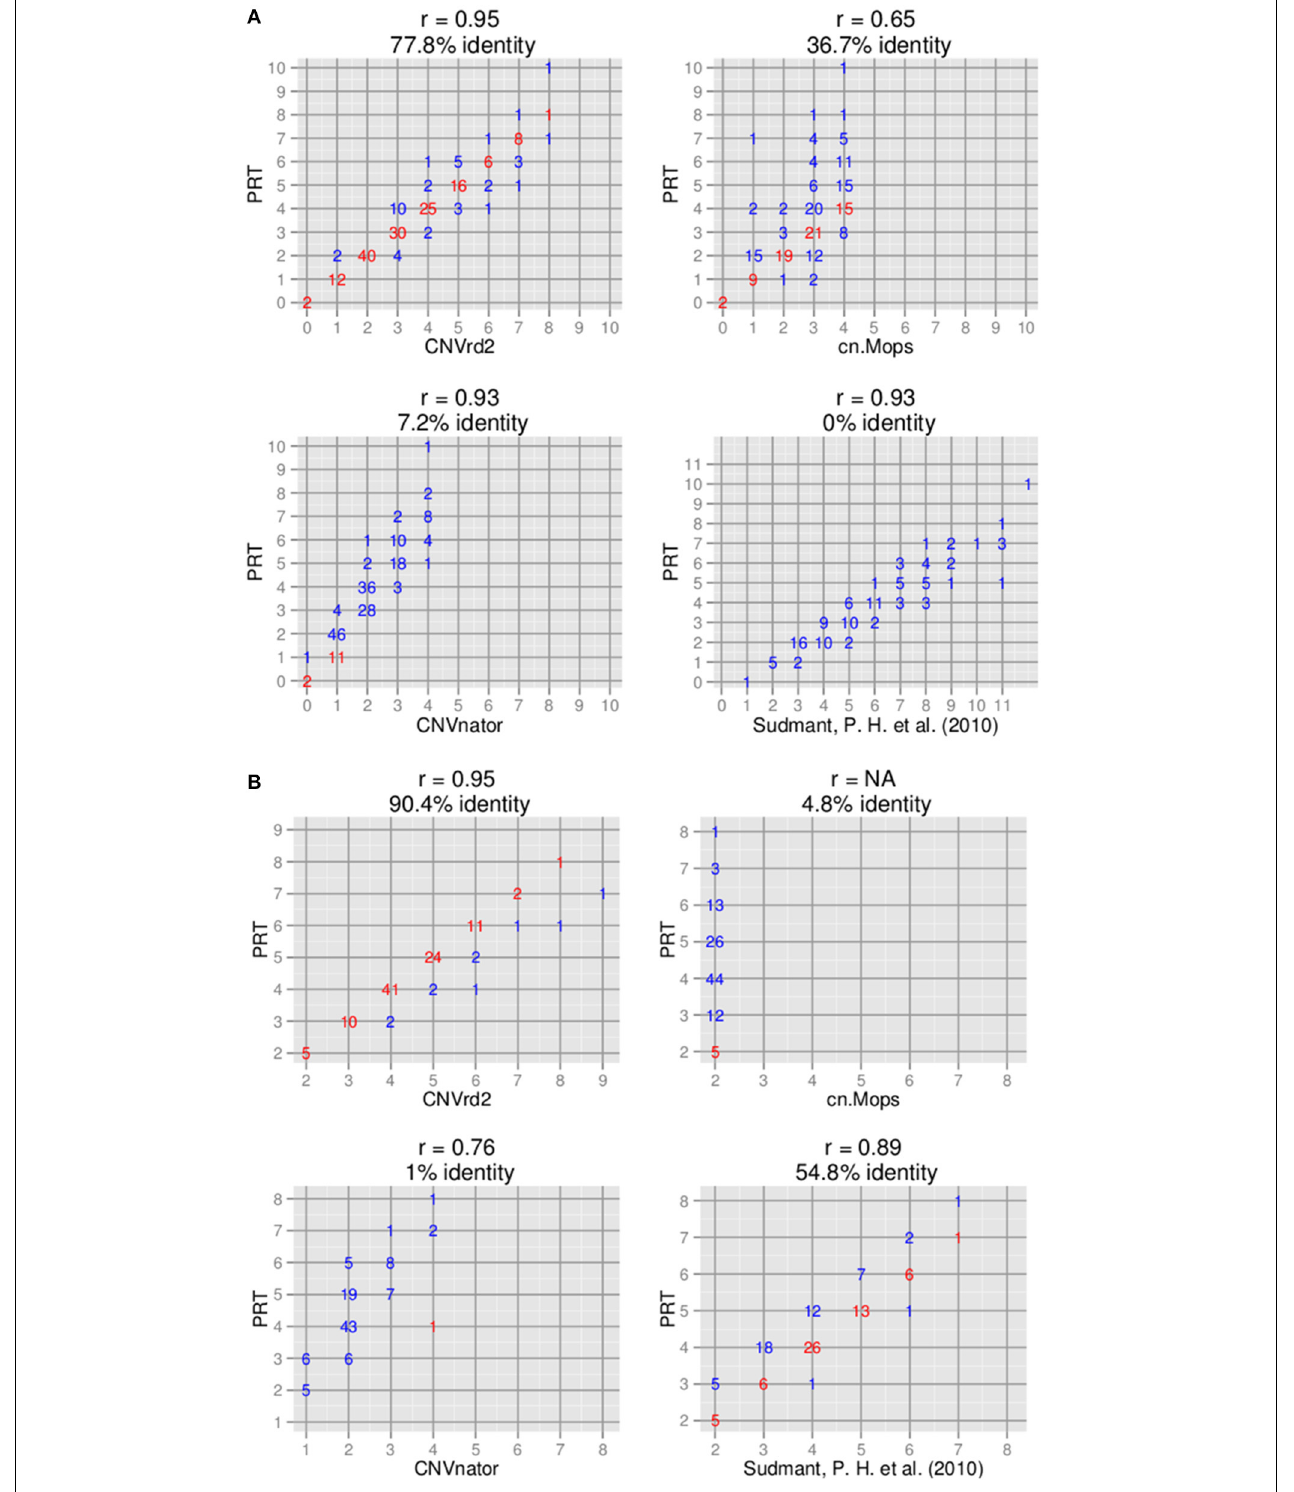
FIGURE 3 | Comparison of copy number assignments of high-throughput sequencing-based with PRT-based methods. (A) CCL3L1 on 180 samples [only 111 samples measured by Sudmant et al. (2010) overlapped]. (B) DEFB103A on 104 samples.